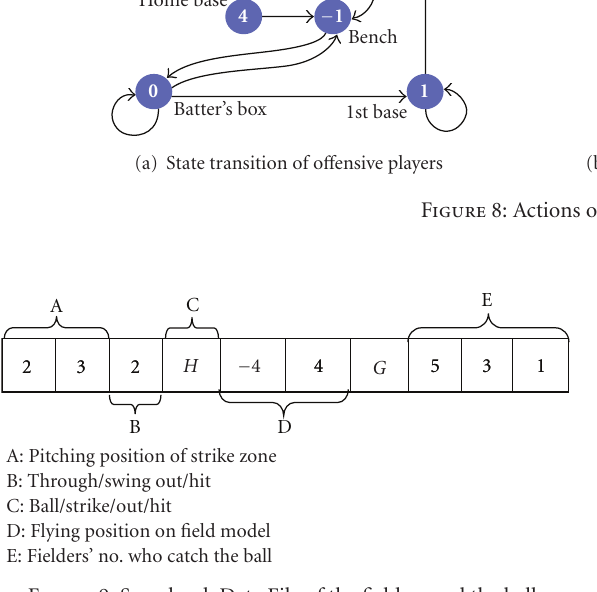
Figure 9: Scorebook Data File of the fielders and the